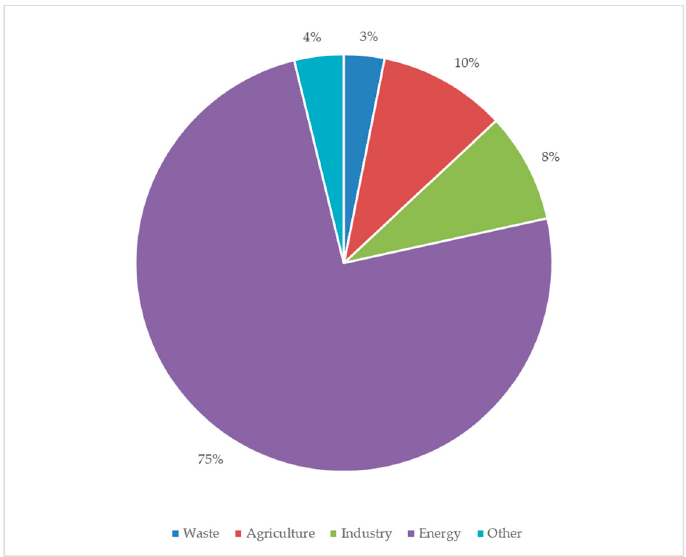
Figure 5. Structure of GHG emissions in the EU in 2018 by sector. Reproduced from [68], Eurostat: 2021.